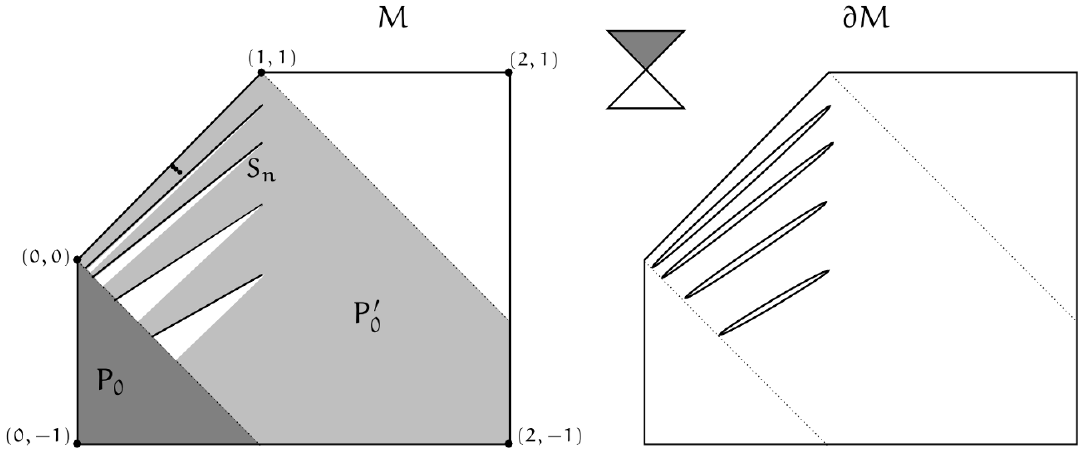
Figure 8 . Let M be an open set of L 2 with the segments S n removed as in the left. Even if the segments are spacelike, the terminal set P 0 (the past of the boundary point ( 1; 1 ) ) contains P 0 (the 0 past of ( 0; 0 )